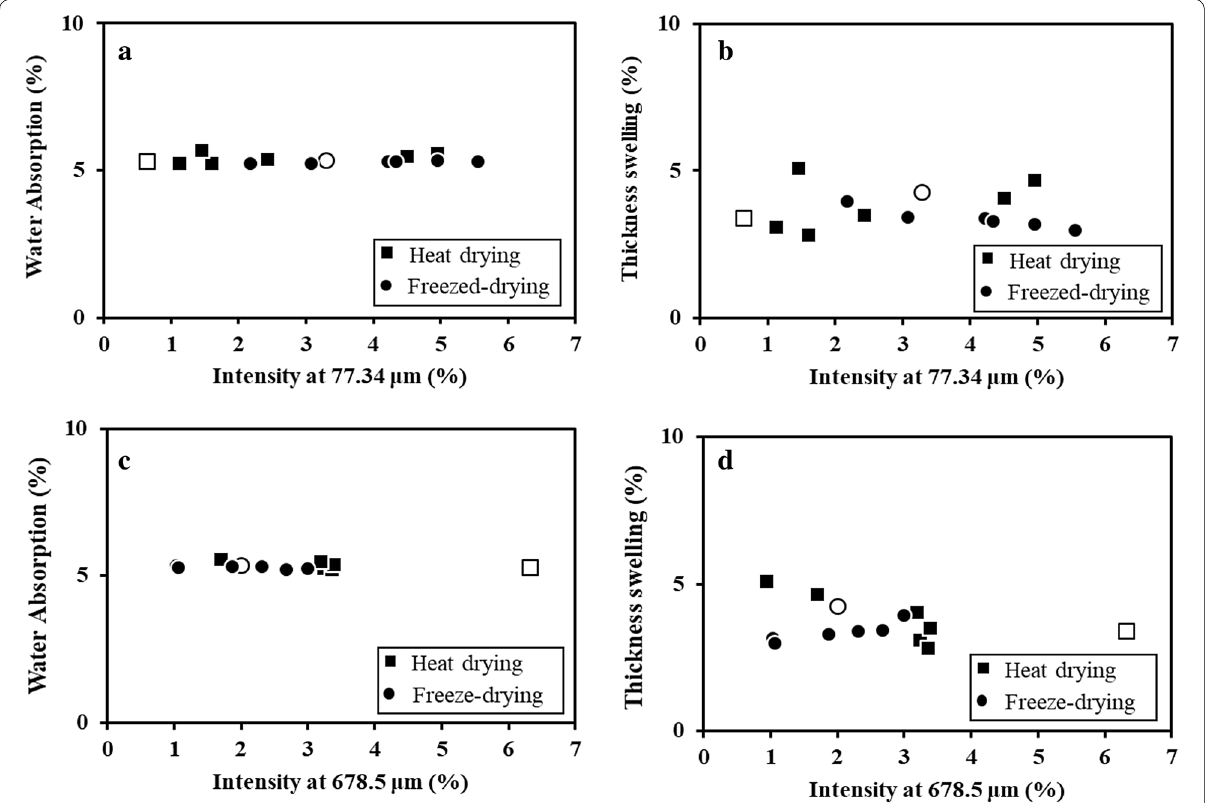
Fig. 10 The relationship between water resistance properties of WPC and the intensity of the particle size distribution: a intensity at 77.3 µm versus water absorption, b intensity at 77.3 µm versus thickness swelling, c intensity at 678.5 µm versus water absorption, and d intensity at 678.5 µm versus thickness swelling. Open square, heat drying 0 min and open circle, freeze-drying 0